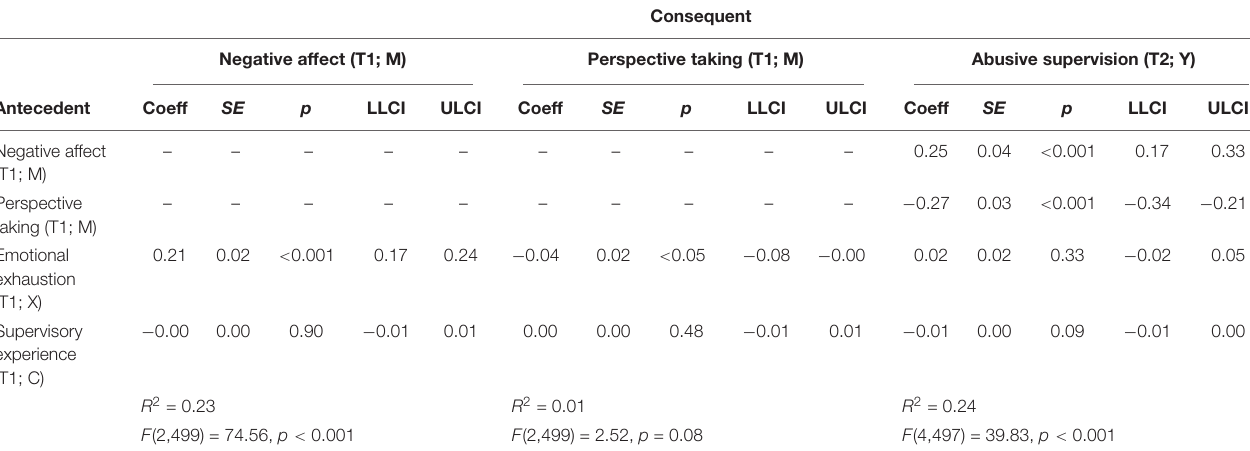
TABLE 3 | Direct and indirect effects model coefficients for effects of emotional exhaustion on abusive